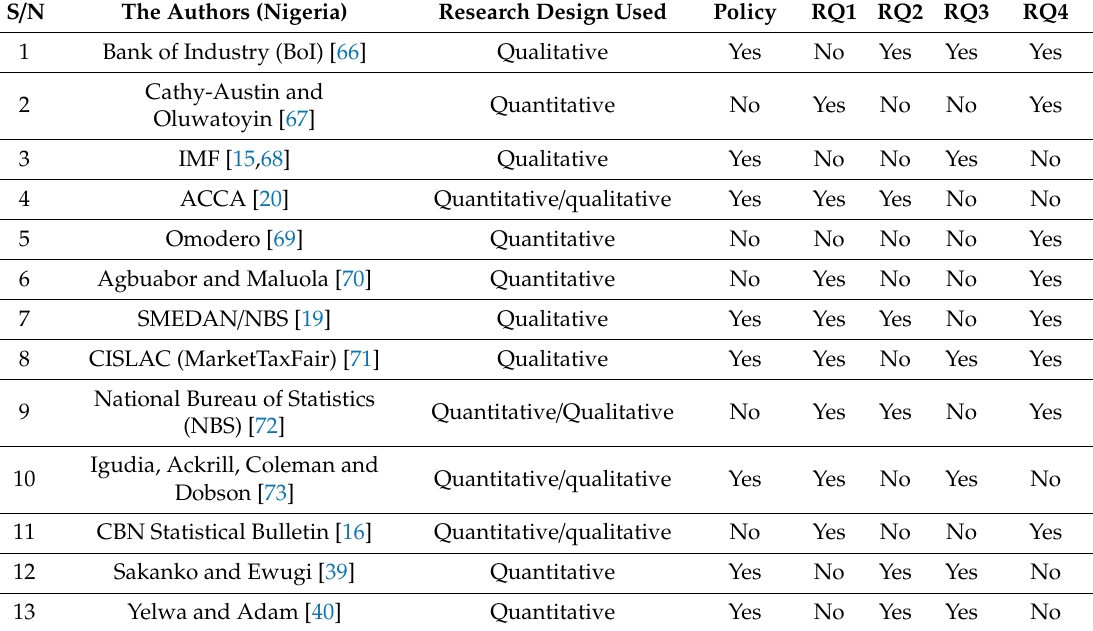
Table 10. Extracted papers on